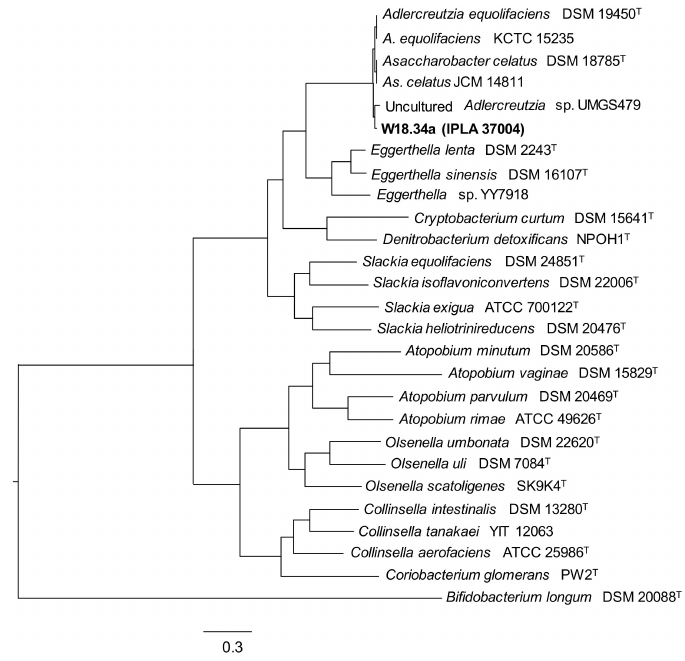
Figure 1. Phylogenetic tree obtained by concatenated alignment of all proteins and genes from the genome sequence of Adlercreutzia equolifaciens W18.34a and other Coriboacteriia species and strains. The genome sequence of Bifidobacterium longum DSM 20088 T was used as an